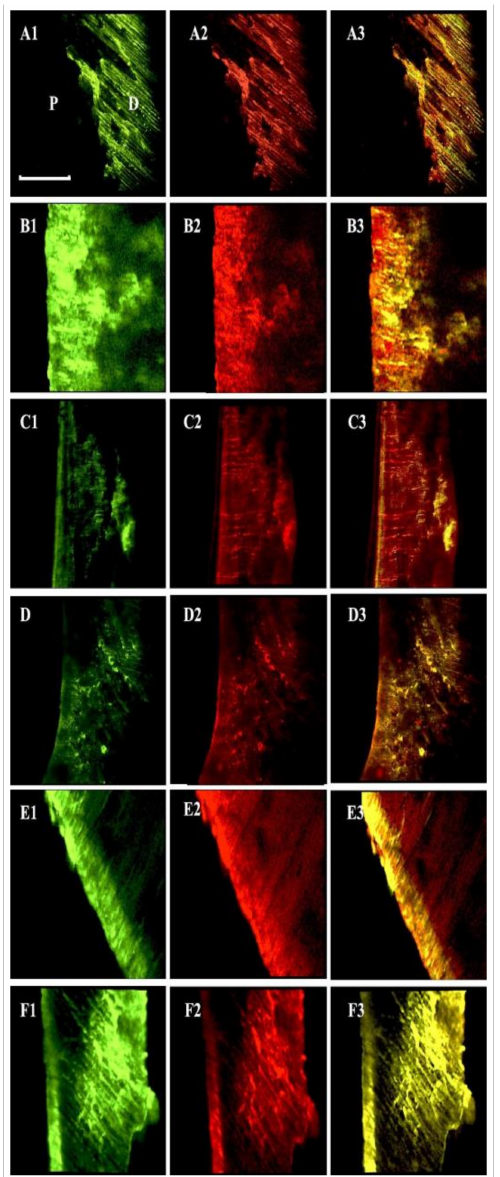
Figure 2. The confocal laser scanning microscopy of the Enterococcus faecalis -infected dentinal tubules, treated with the di ff erent antibacterial pastes, after viability staining. Two-dimensional images of the green channel ( A1 – F1 ); two-dimensional images of the red channel ( A2 – F2 ); two-dimensional images of the composite reconstruction ( A3 – F3 ). 3-MIX with HA ( A1 – A3 ); 3-MIX with MG ( B1 – B3 ); 3-MIXC with HA ( C1 – C3 ); 3-MIXC with MG ( D1 – D3 ); 2MIX with HA ( E1 – E3 ); 2-MIX with MG ( F1 – F3 ). 2MIX: ciprofloxacin and metronidazole; 3-MIX: ciprofloxacin, metronidazole and minocycline; 3-MIXC: ciprofloxacin, metronidazole and clarithromycin; hyaluronic acid (HA); macrogol gel (MG); dentin (D); pulpal side (P). The scale line length is 300 µ